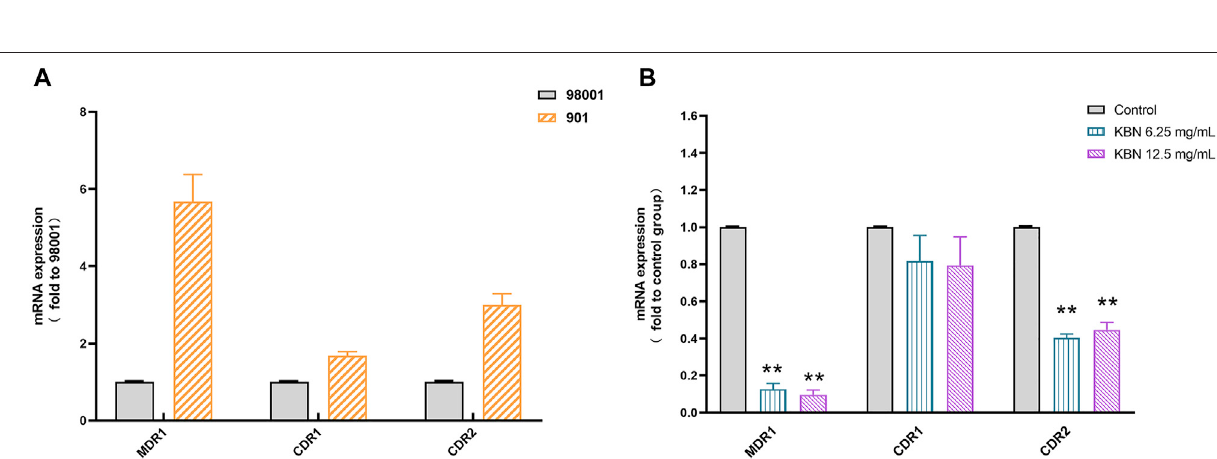
Frontiers in Pharmacology |